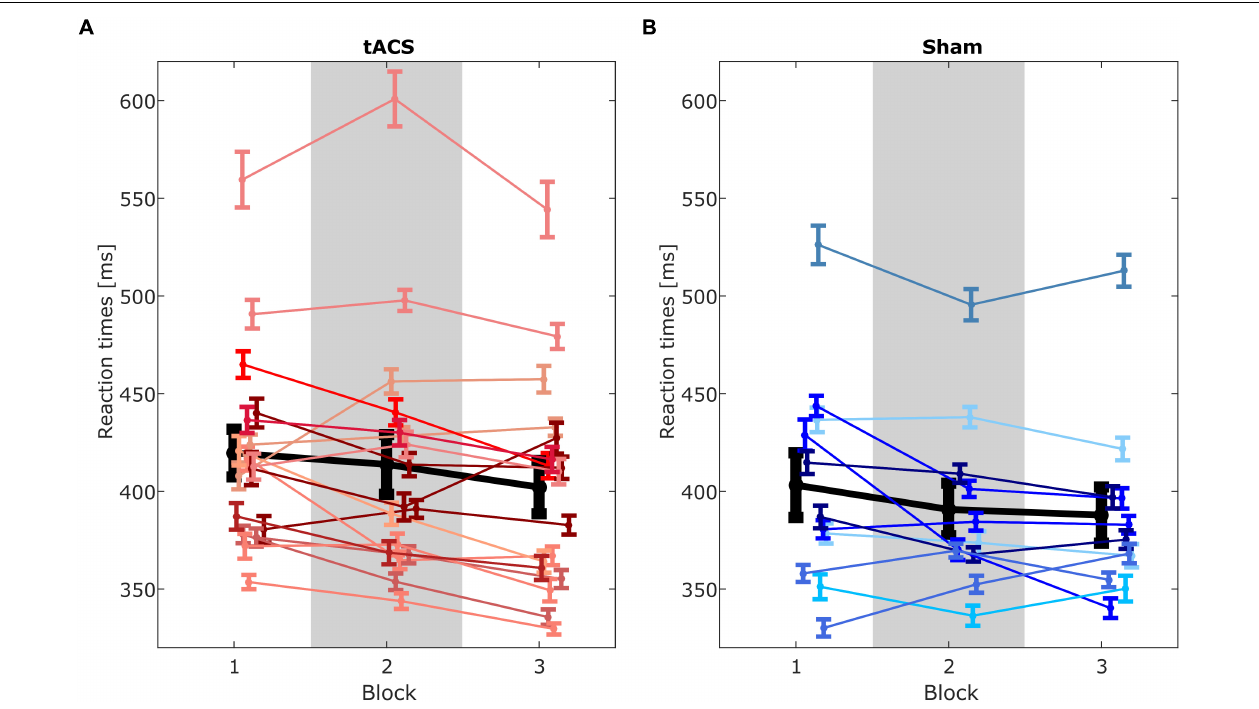
FIGURE 4 | Reaction times of single subjects for (A) tACS group and (B) sham group. Each line represents means of reaction times of a single subject for each block. Lines linking block means illustrate changes between blocks. Error bars depict standard error of the mean. Group means shown in black. Gray rectangle marks block 2 in which stimulation was